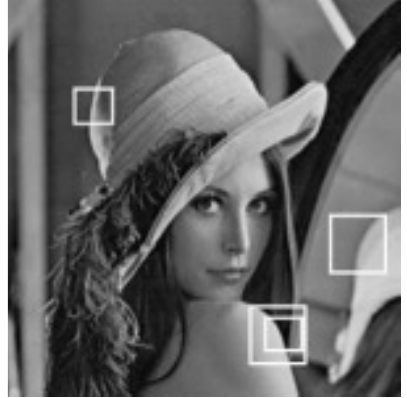
Figure 28. Self-similarity in the Lena